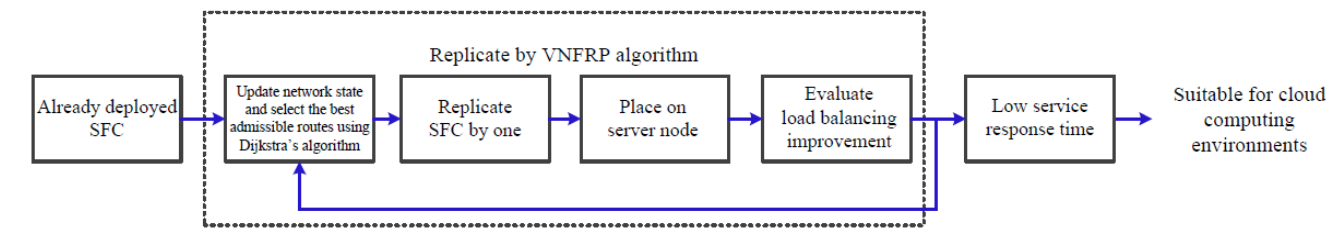
Figure 1. The architecture of the virtual network functions and their replica placement (VNFRP) algorithm.